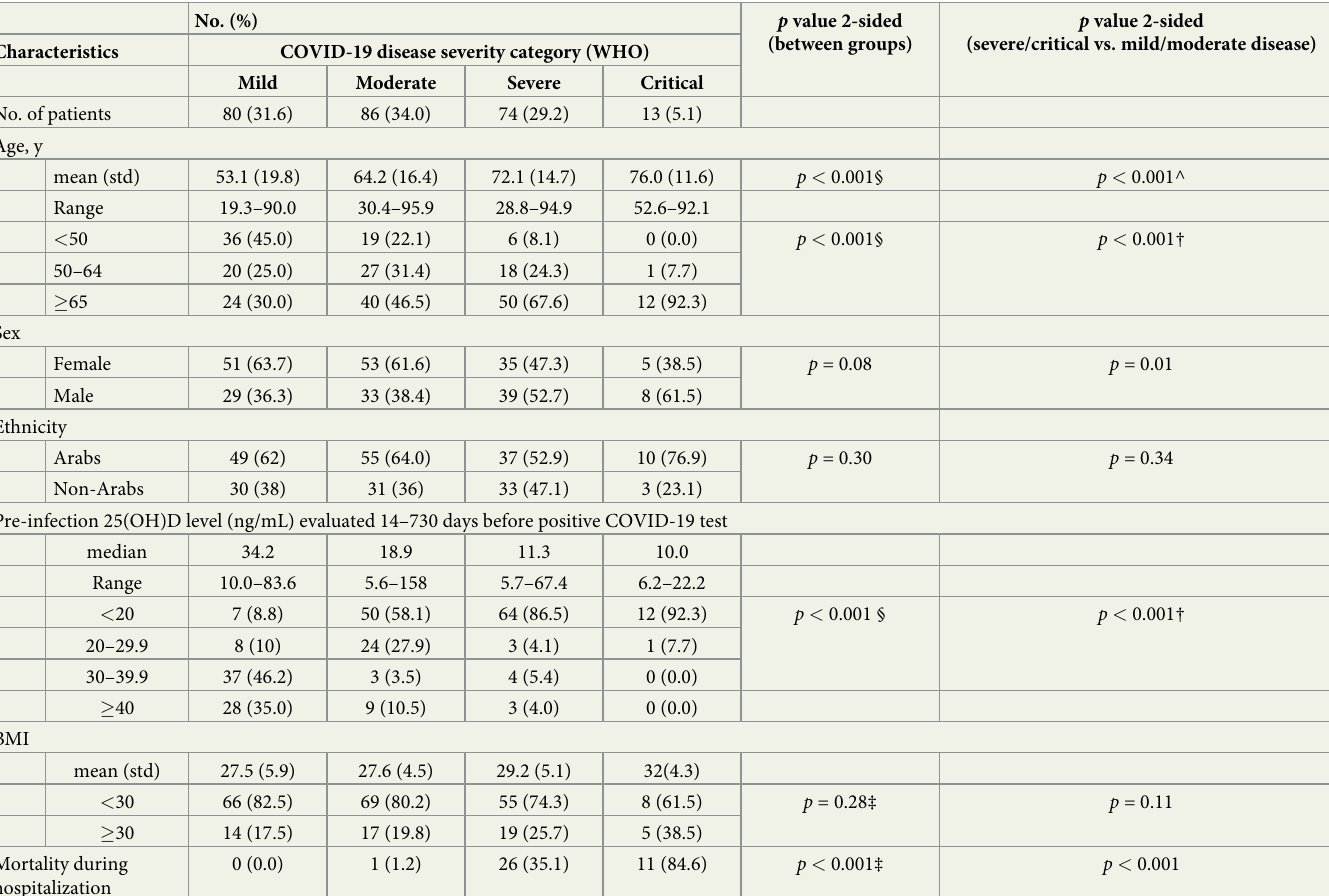
Table 2. Characteristics of hospitalized COVID-19 patients and their pre-infection measurement of 25(OH)D levels, stratified by COVID-19 disease severity category. No.